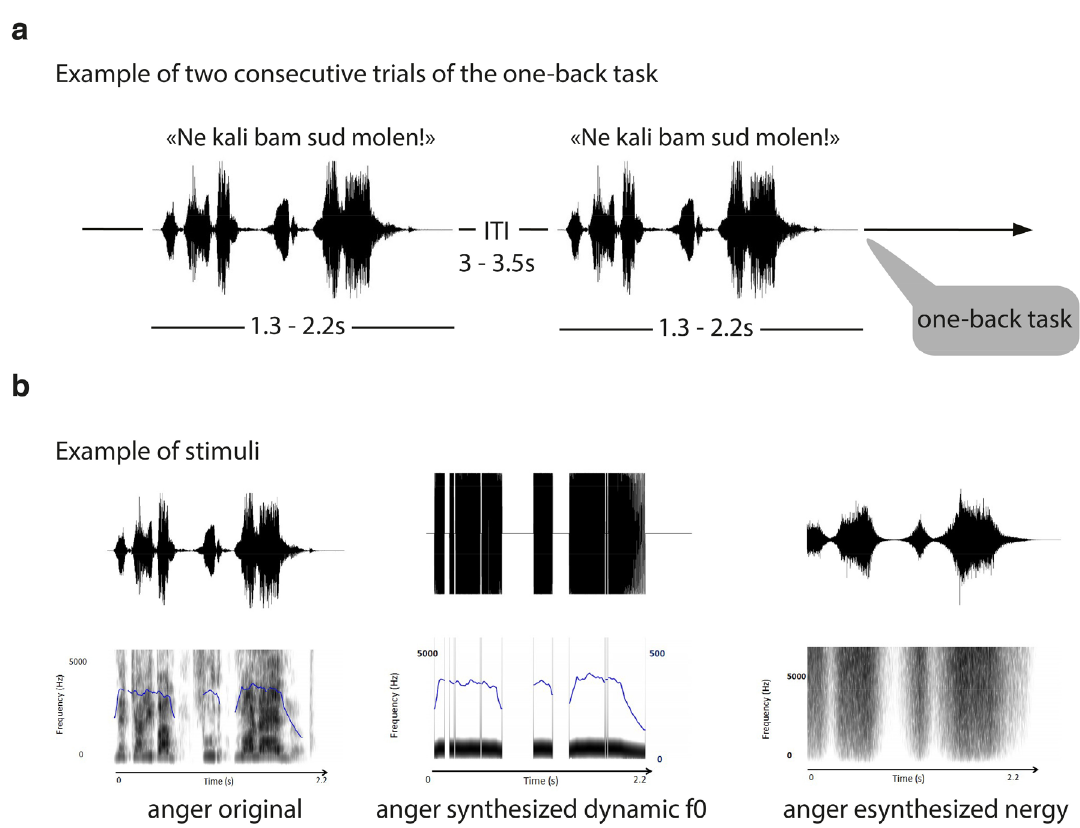
Figure 6. Experimental timeline and details of stimuli for the one-back task. ( a ) Following technical scans (localizer and field map), the first run started for 10 min during which participants had to perform a one-back task on the voice presented auditorily to them using an MRI-compatible button box. The second run followed similarly for 10 more minutes and the session ended with the acquisition of an anatomical image for 5 min. During the complete session, the participant laid down in the scanner and had to pay attention to auditorily presented vocal stimuli and do a one-back task (10% of all trials). All stimuli had a duration of 1.3–2.2 s and an inter trial interval of 3–3.5 s. ( b ) Voice stimuli consisted of pseudowords arranged in sentences with either original vocal signal, synthesized dynamic f 0 manipulation or synthesized